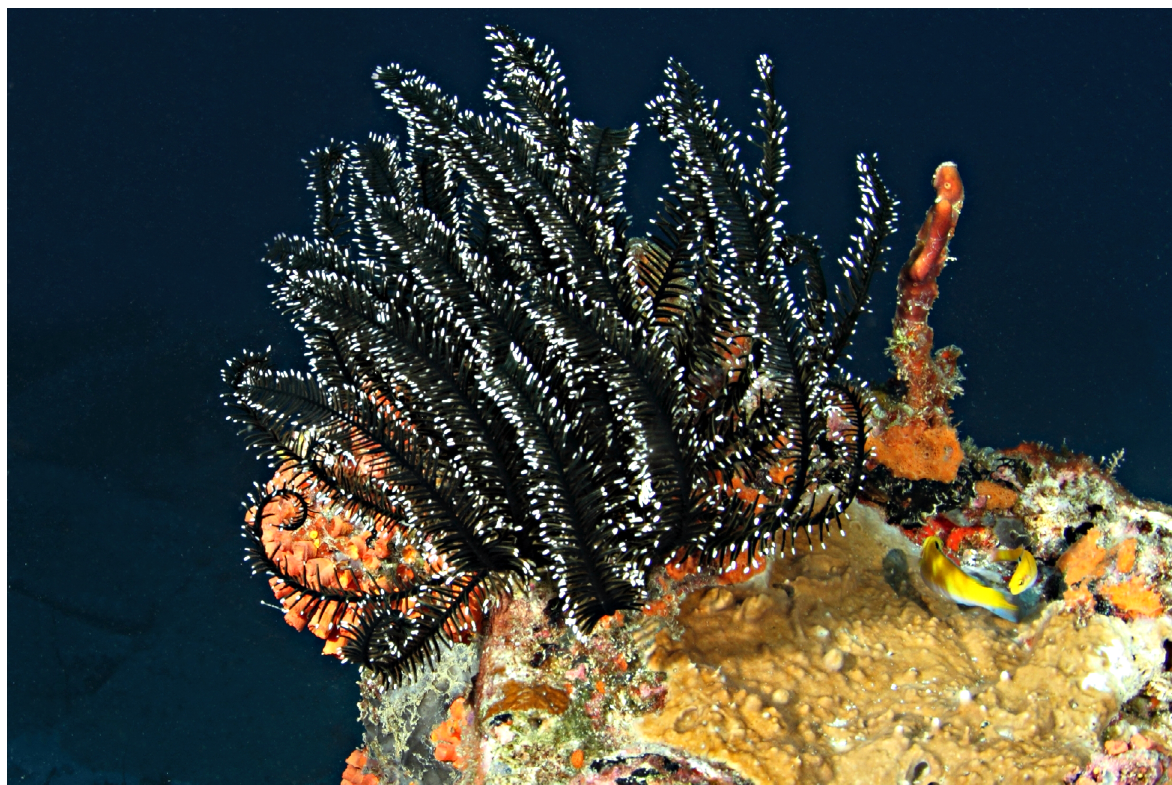
Figure 1. Crinoid Nemaster grandis , in Chichiriviche de la Costa, Vargas State.